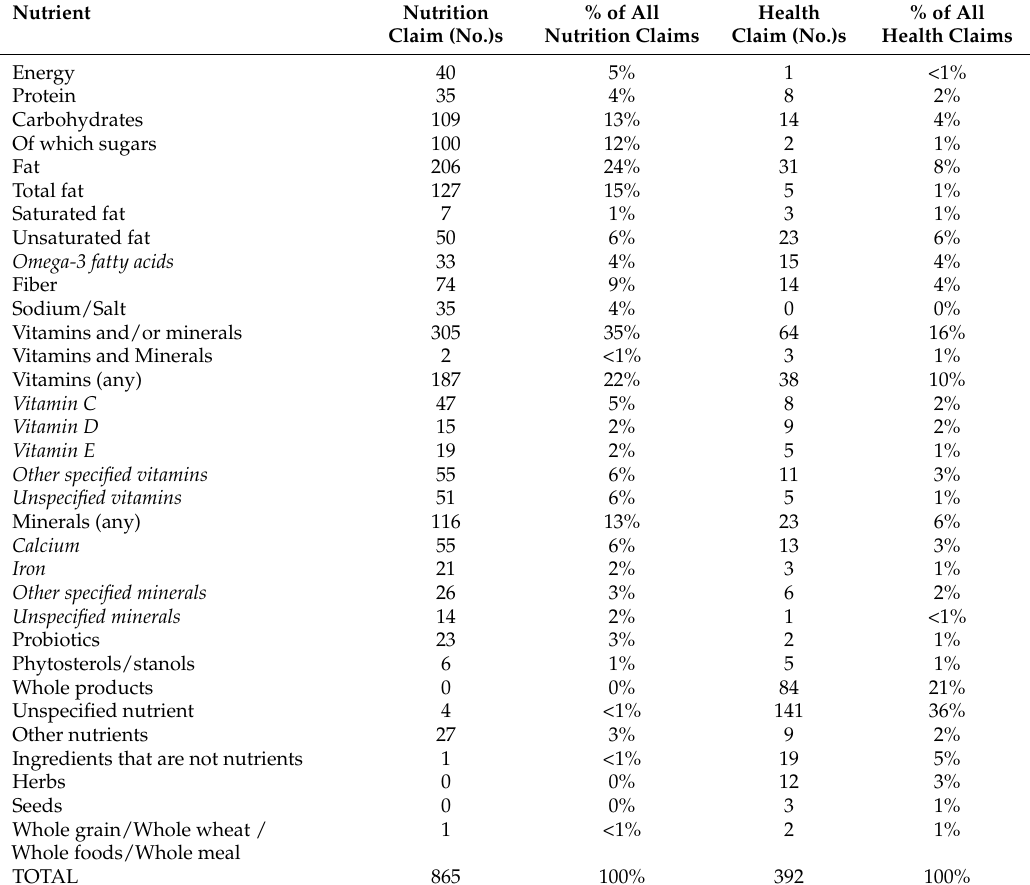
Table 4. Nutrients and ingredients referred to in nutrition and health claims (all five